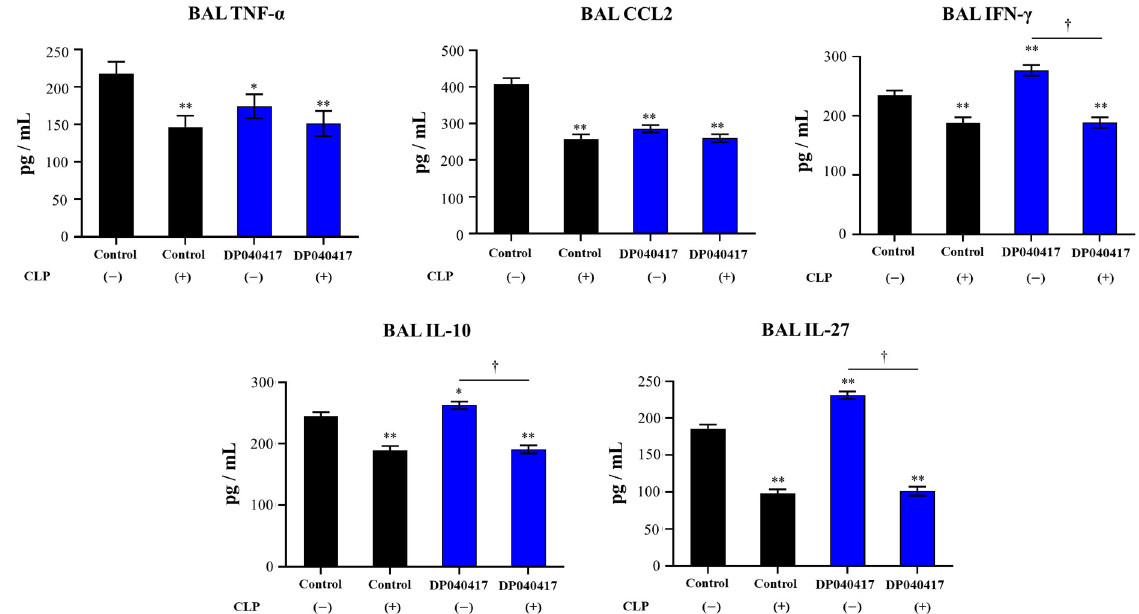
Figure 9. Effect of alveolar macrophages depletion on the ability of the respiratory commensal bacteria Dolosigranulum pigrum 040417 to improve protection against Streptococcus pneumoniae infection. Infant mice were nasally treated with clodronate-containing liposomes (CLP) during 2 days (days 0 and 1) to induce the depletion of alveolar macrophages. One day after the last CPL administration, mice were nasally treated with viable D. pigrum (DP) strain 040417 (10 8 cell/mouse/day) during five consecutive days (days 2–6) and challenged with S. pneumoniae serotype 3 on day 7. Mice treated with liposomes and then challenged with S. pneumoniae were used as controls. Tumour necrosis factor (TNF)- α , chemokine (C–C motif) ligand 2 (CCL2), and interferon (IFN)- γ in broncho-alveolar lavages (BAL) were evaluated 2 days after the pathogen challenge. Interleukin (IL)-10 and IL-27 in BAL were evaluated 5 days after the pathogen challenge. The results represent data from three independent experiments ( n = 6 per group). Significantly different when compared with control CLP ( − ) group, * p < 0.05 or ** p < 0.01. Signi fi cantly di ff erences between the indicated groups, † p < 0.05.